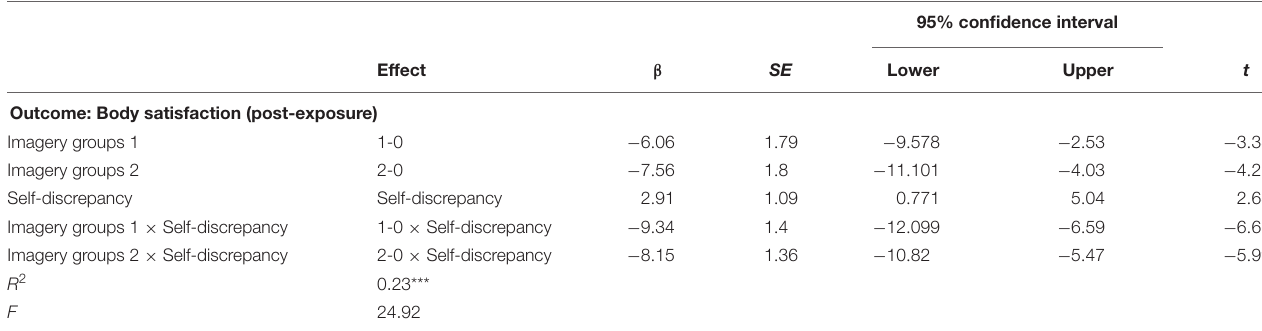
TABLE 2 | The results of moderation analysis.